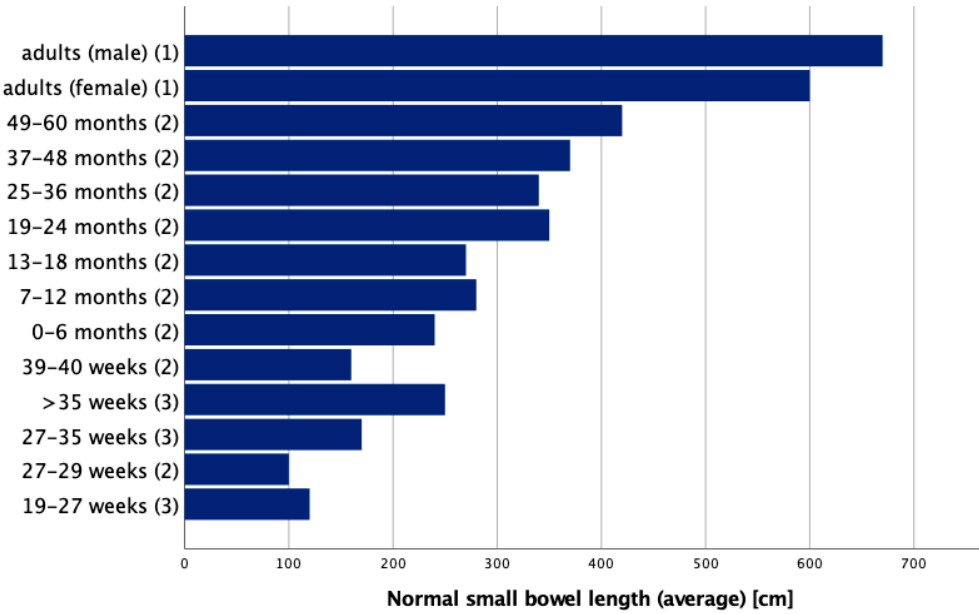
Figure 1. Normal small bowel lengths in various ages adapted from ( 1 ) Hounnou et al.; ( 2 ) Struijs et al.; ( 3 ) Touloukian et al. [8–10].